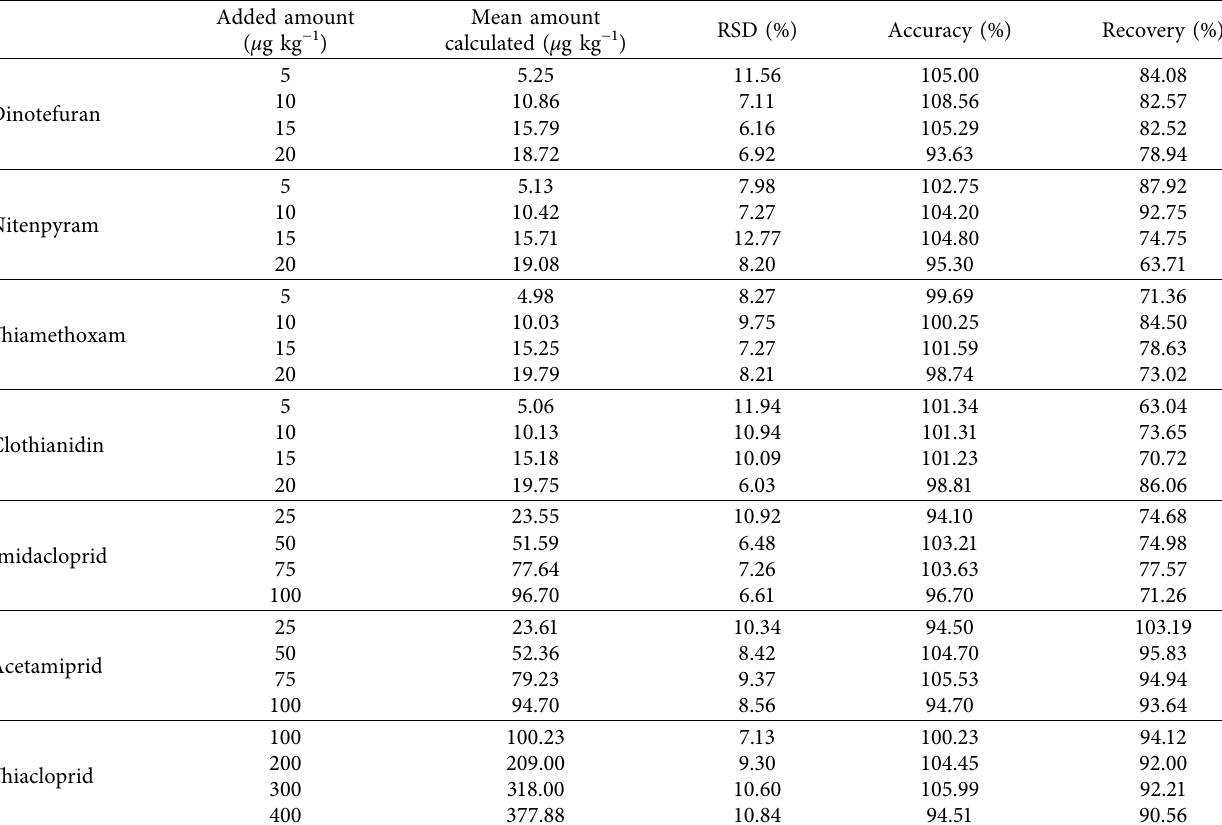
Table 3: Accuracy and recovery of neonicotinoids in honey